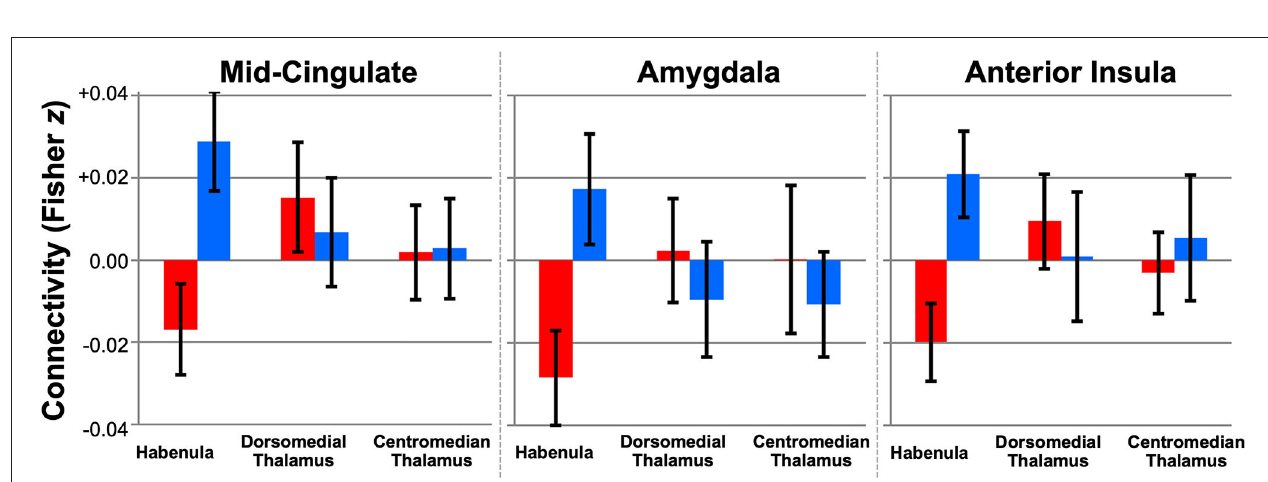
FIGURE 7 | Altered habenula RSFC in young adults from the Human Connectome with high subclinical depression ( N = 25, red) vs. low subclinical depression ( N = 25, blue). Plots show seed-to-cluster RSFC values (mean ± 95% CI) for three clusters (mid-cingulate, amygdala, anterior insula) where habenula RSFC differed between groups (exploratory p uncorrected < 0.001, k ≥ 10). No group differences in RSFC were detected for adjacent seeds in the dorsomedial or centromedian thalamus with the same clusters. Excerpted from (154).